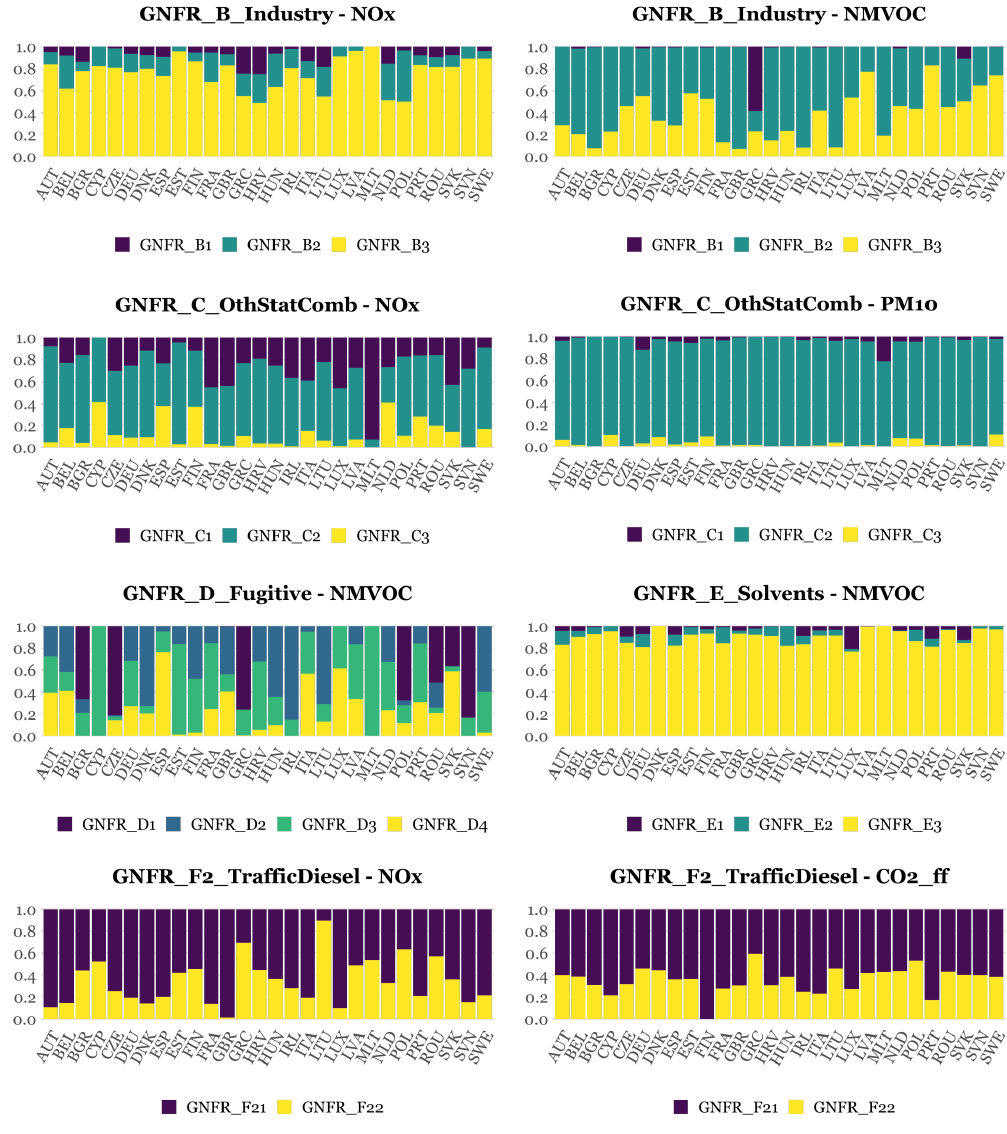
Figure 3. Average contribution of each GNFR subcategory (see definitions in Table 2) to total annual emissions for selected pollutants per country (EU27 + UK) for the year 2020. Country abbreviations follow the ISO 3166-1 alpha-3 code standard (https://www.iban.com/ country-codes, last access: May